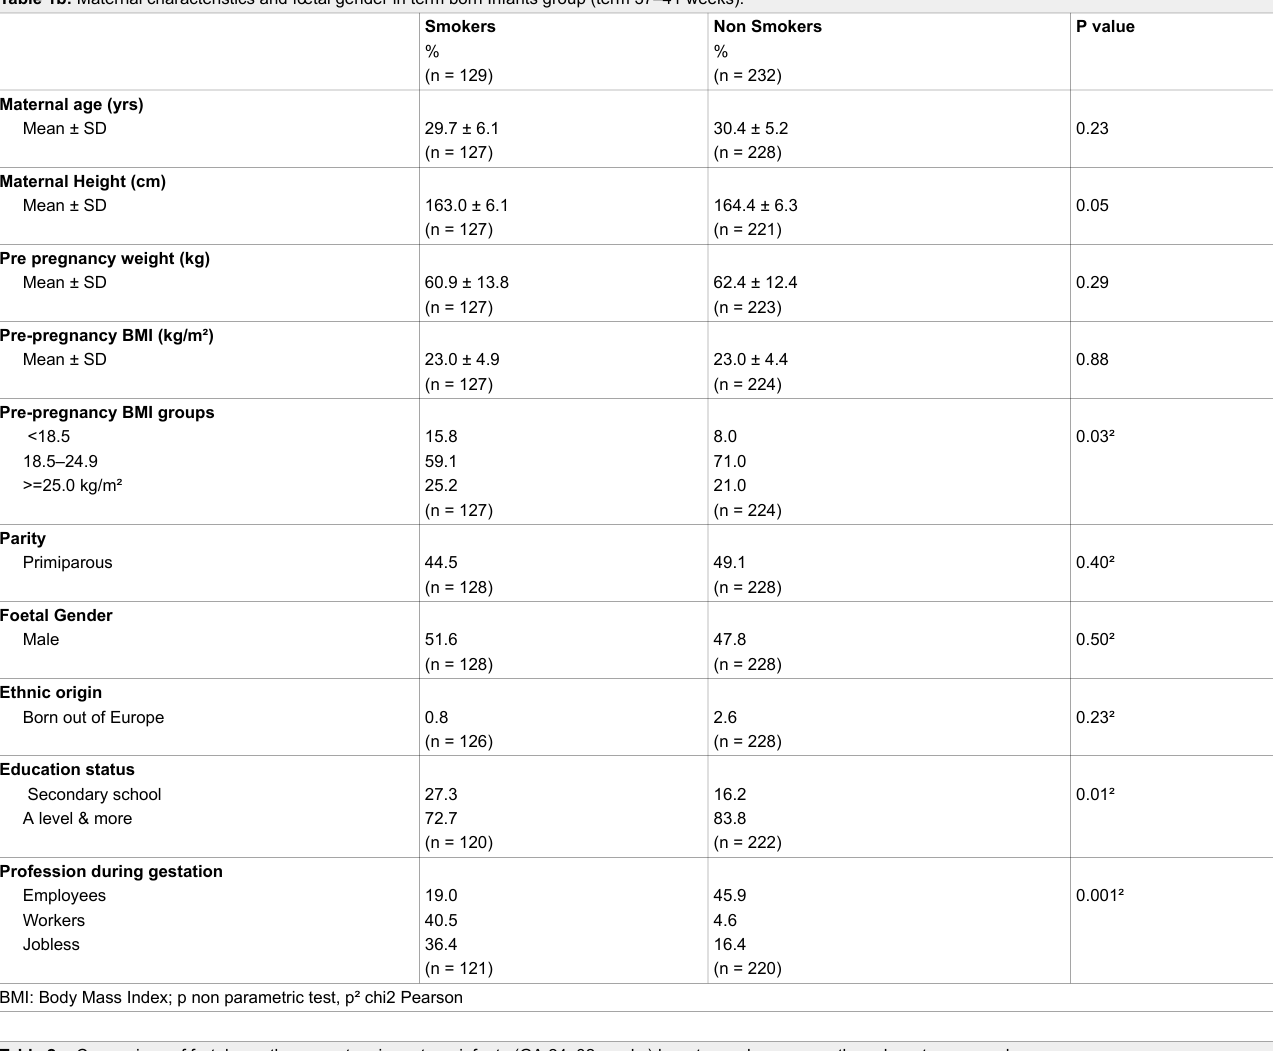
Table 1b: Maternal characteristics and fœtal gender in term born Infants group (term 37–41 weeks).